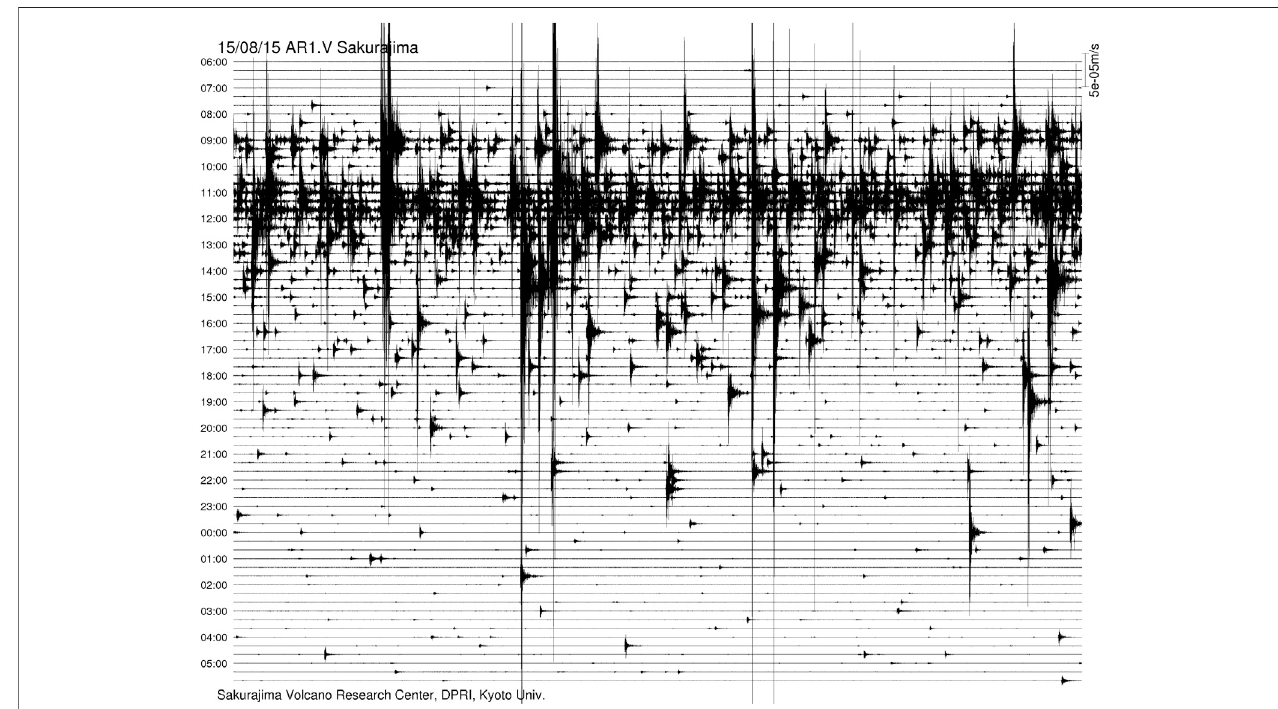
FIGURE2| Continuousseismogramoftheverticalcomponentofashort-periodseismometeratstationAR1recordedfrom6AMonAugust15to6AMonAugust 16, 2015 (Japan Standard Time, JST).